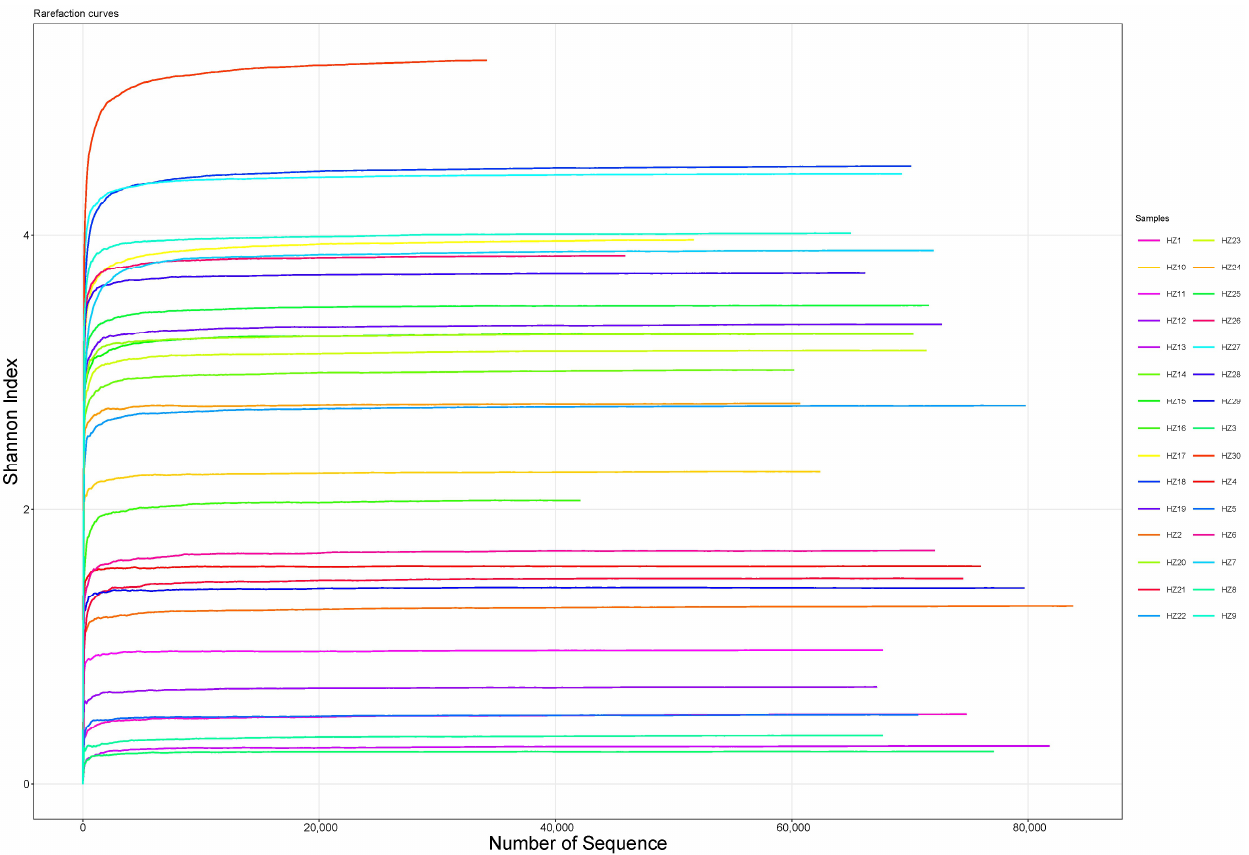
Figure 1. Rarefaction curve plot of 30 black-billed capercaillie samples. In the rarefaction curves, the abscissa is the number of sequencing samples randomly chosen from the sample, and the ordinate is the number of OTUs. Each line represents the gut microbiome of a black-billed capercaillie sample.